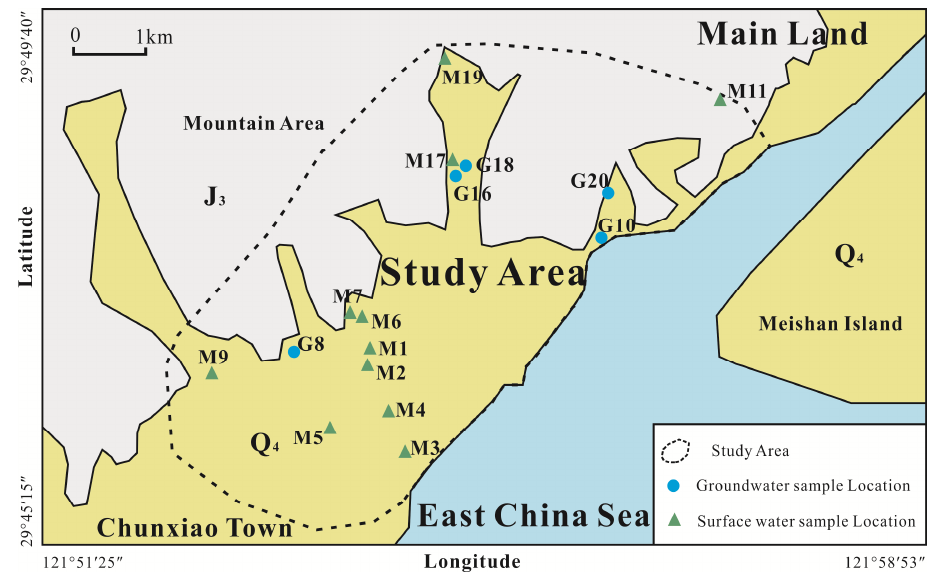
Figure 2. Water sample location.